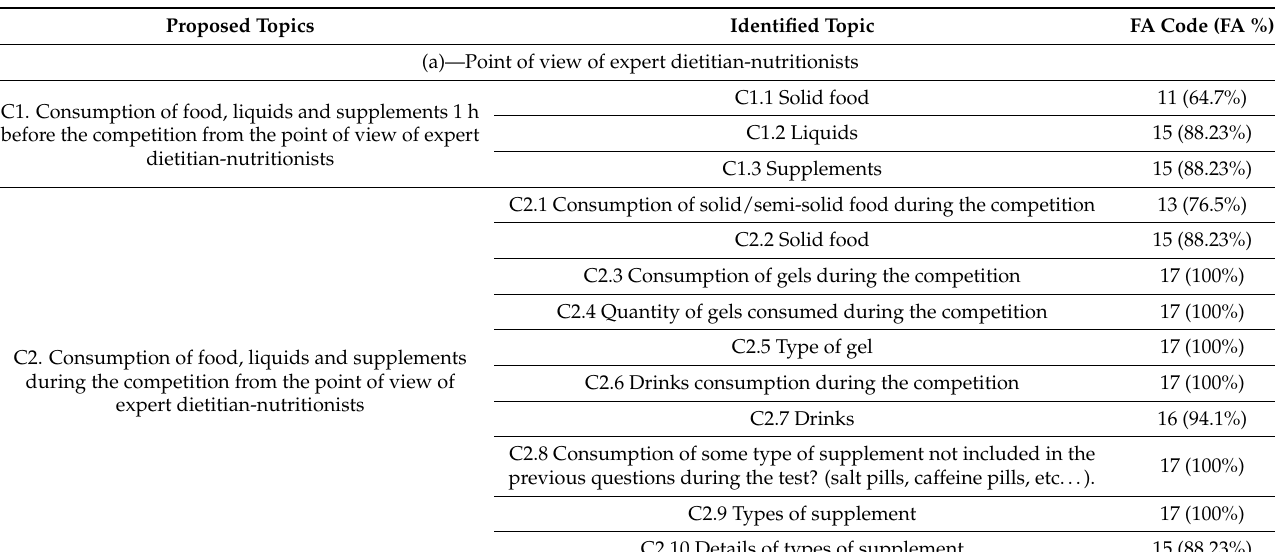
Table 3. a. Results of the focus groups for the content of part III of the questionnaire, referring to the consumption of liquids, food and supplements one hour before, during and the hour after the competition from the point of view of expert dietitian-nutritionists. b. Results of the focus groups for the content of part III of the questionnaire, referring to the consumption of liquids, food and supplements one hour before, during and the hour after the competition from the point of view of the